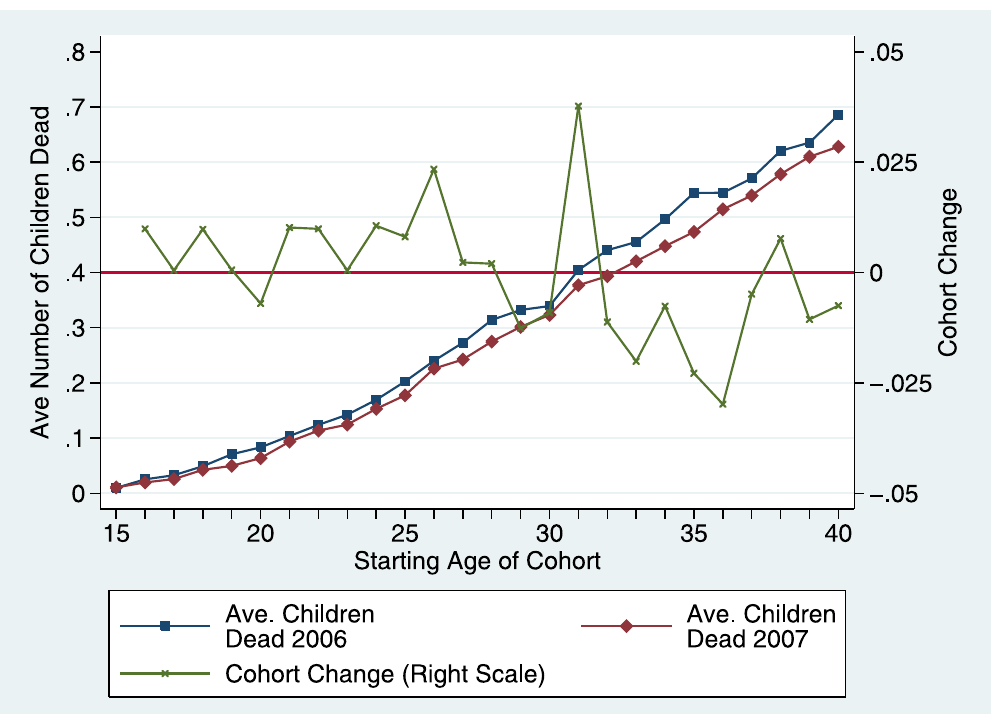
Fig 5. Average numbers of children dead by rolling 5-year cohorts: Ghana 2006 MICS and 2007 MMS. This figure shows the average number of children dead reported by women in rolling five year age groups from 15 – 19 to 40 – 44 from two surveys in Ghana separated by one year, and the changes by cohort from one survey to the